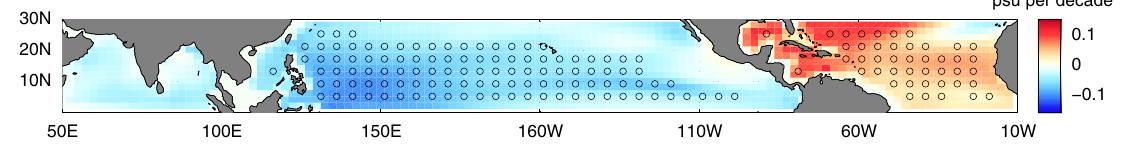
Figure 5 | Projected 100-year changes in surface salinity. Ensemble mean change in sea surface salinity (psu per decade), averaged over the typhoon season (June–November), under the RCP 8.5 scenario. Change is defined as the difference between the mean over the 20-year periods 2081–2100 and 1981–2000. Locations with statistically significant changes are marked with